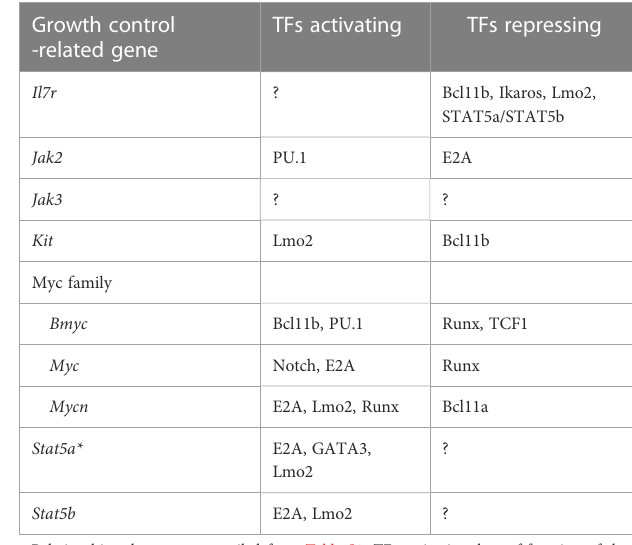
TABLE 1 Inputs to growth control genes from developmental network